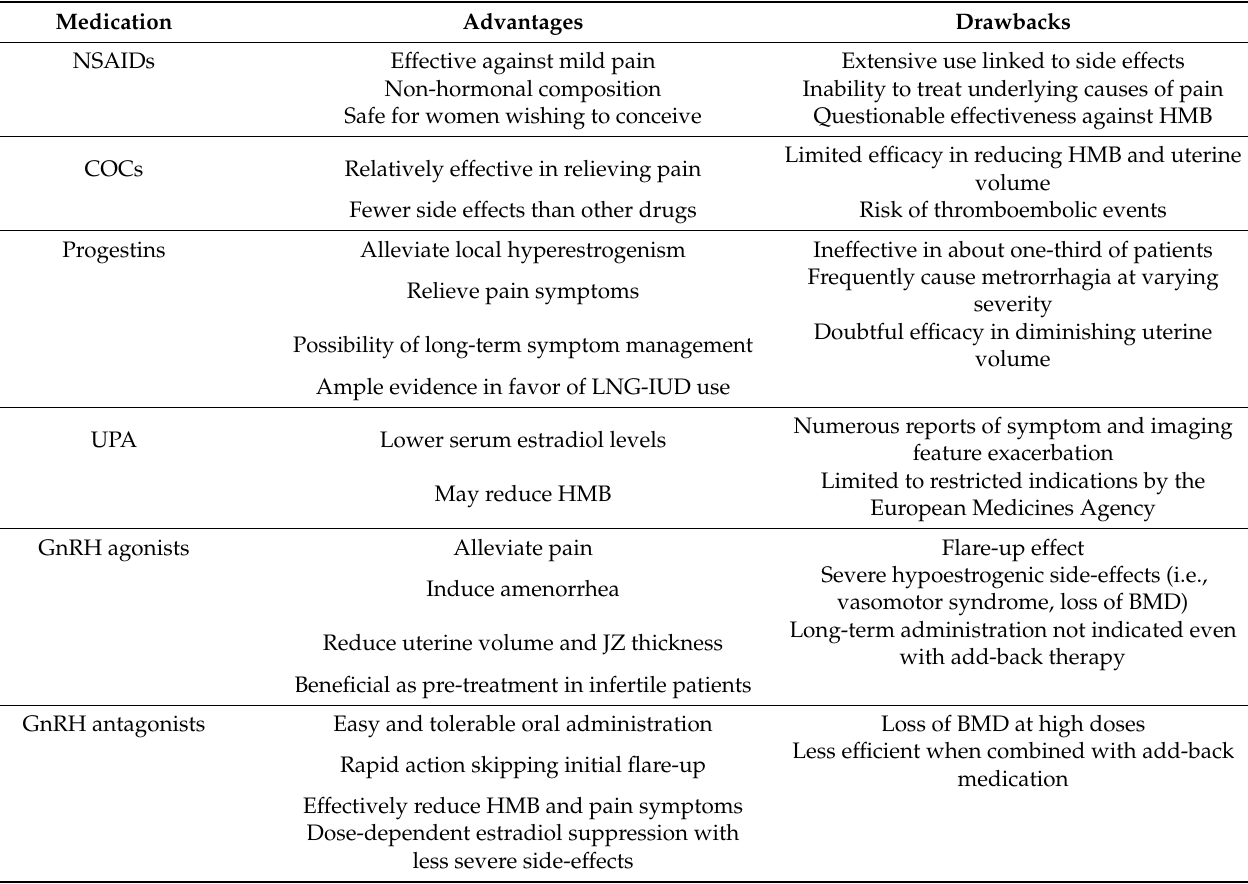
Table 1. Advantages and drawbacks of the main drug groups used against adenomyosis symptoms. Medication Advantages Drawbacks